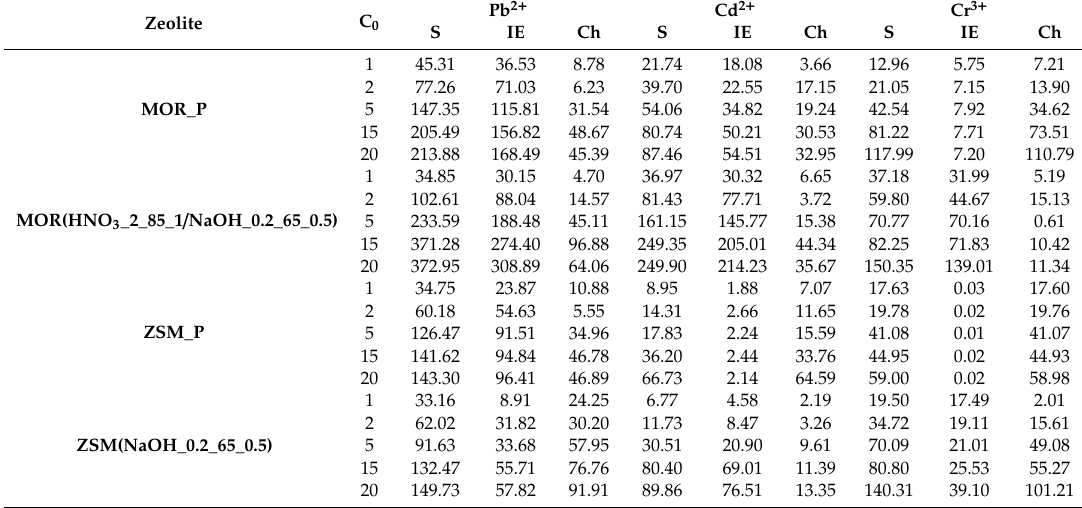
Table 4. Sorption results of heavy metal cations on mordenite and ZSM-5 zeolite as a function of concentration.